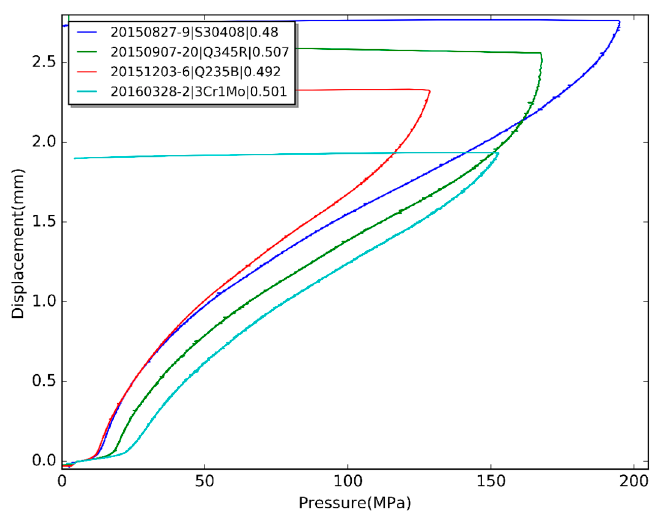
Figure 12. Comparing the results from HBT with conventional tensile test.